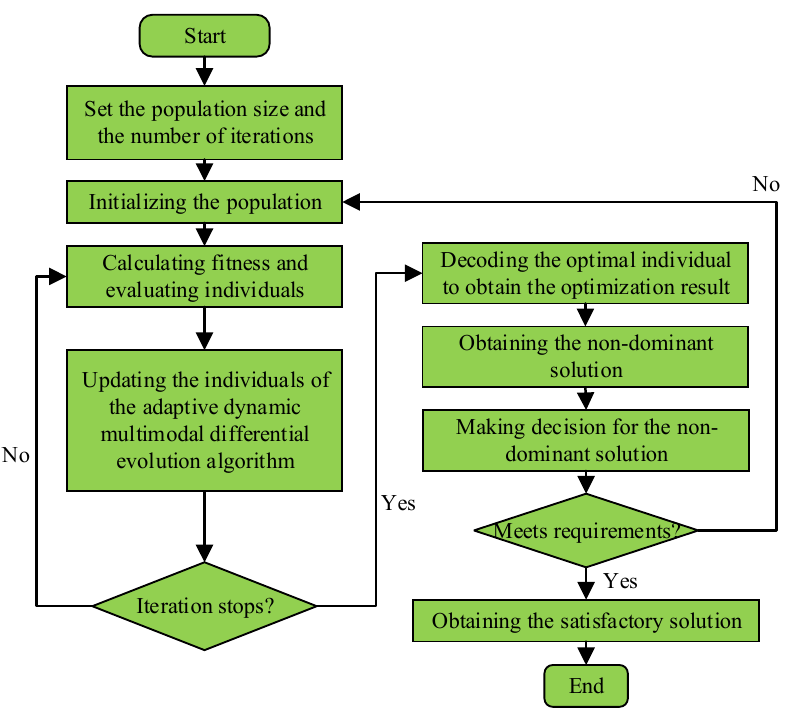
Figure 2. Overview of energy-saving optimization